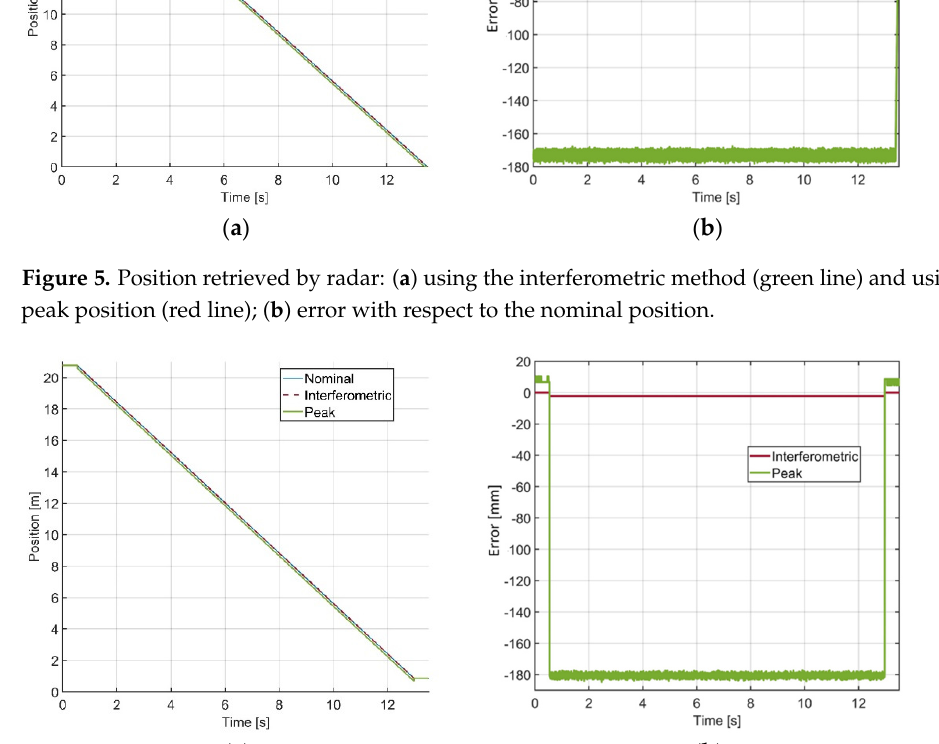
Figure 6. Position retrieved by radar: ( a ) using the interferometric method (green line) and using the peak position (red line); ( b ) error with respect to the nominal position.